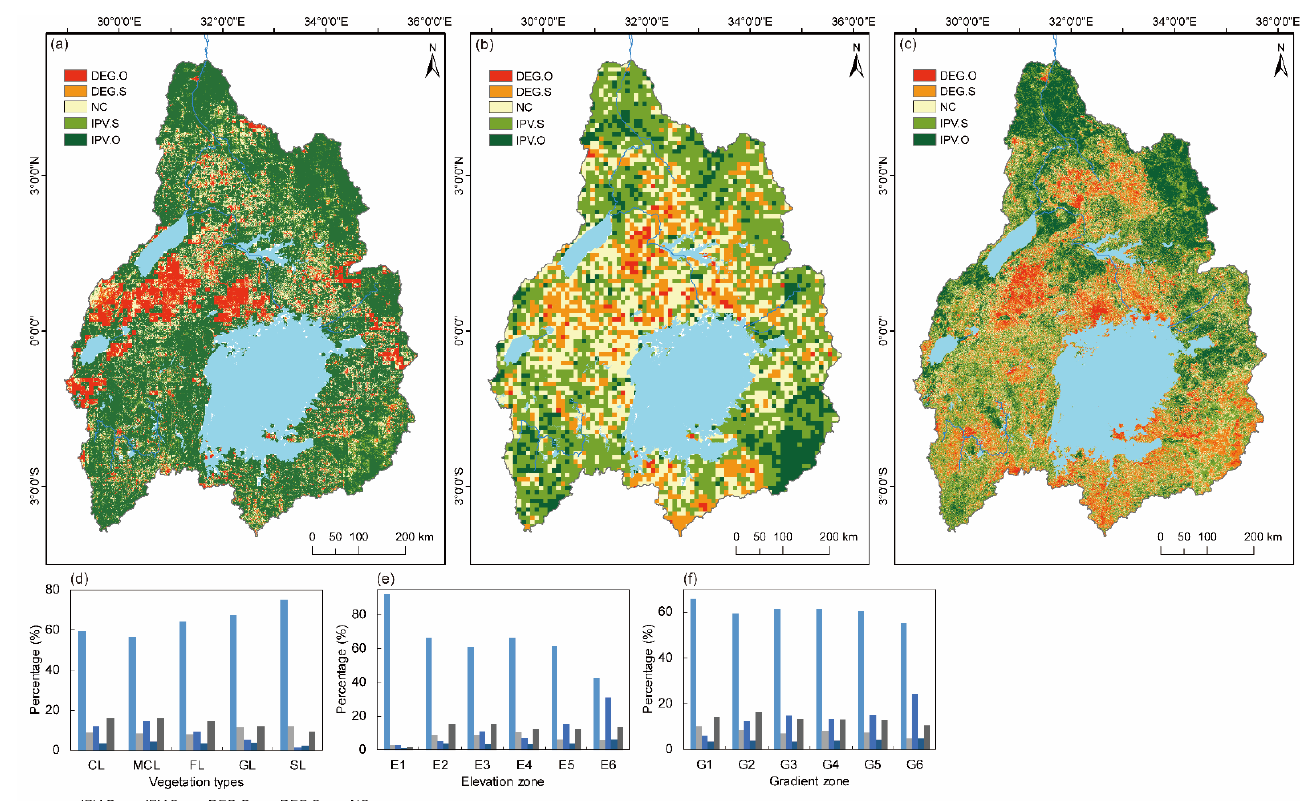
Figure 6. Vegetation change trends in different stages: ( a ) Vegetation trend from 1982 to 2020. ( b ) Vegetation trend from 1982 to 1999. ( c ) Change trend from 2000 to 2020. ( d ) Change trend under different vegetation types from 1982 to 2020. ( e ) The change trend of vegetation in different elevation zones from 1982 to 2020. ( f ) The change trend of vegetation in different slope zones from 1982 to 2020. Note: IPV.O means that the vegetation is significantly improved, IPV.S means that the vegetation is slightly improved, DEG.S means that the vegetation is slightly degraded, DEG.O means that the vegetation is significantly degraded, and NC means that the vegetation is relatively stable. Table 3. Trend of NDVI in the UWNR.